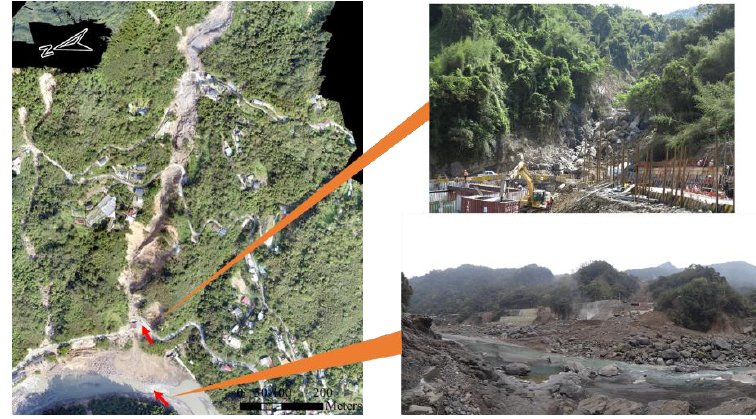
Figure 16. Landslide deposition